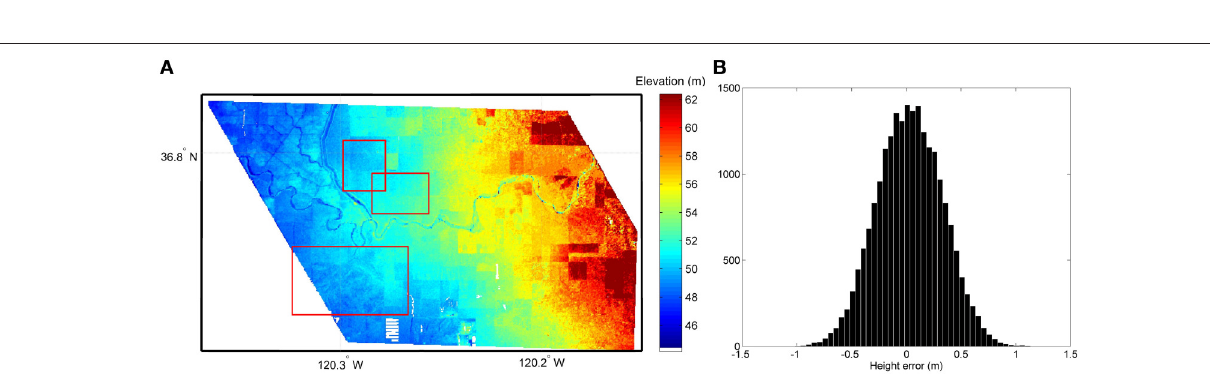
Frontiers in Earth Science |